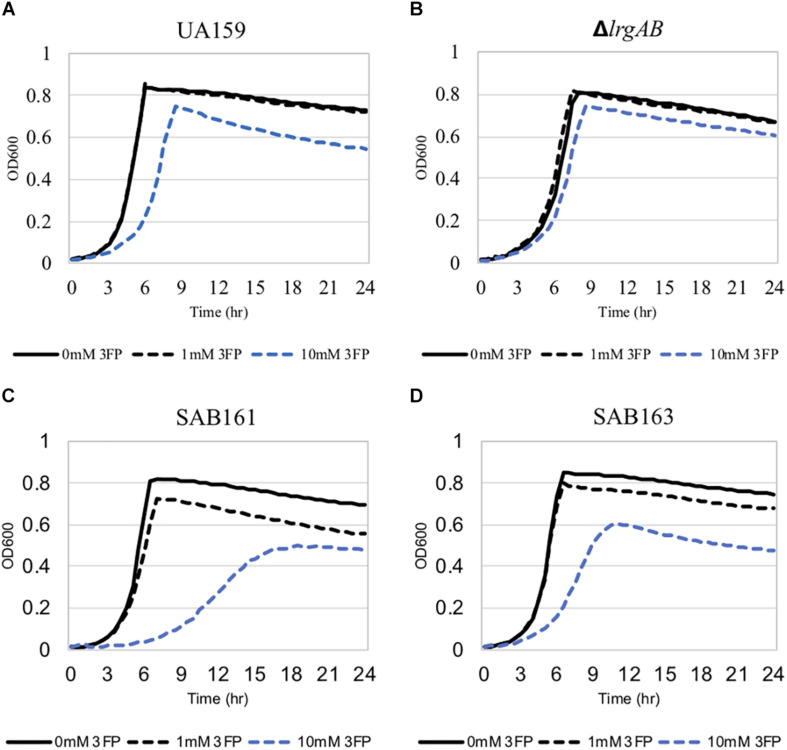
The effect of 3-fluoropyruvate (3FP; pyruvate analog) on the growth of the lrg-derivative strains. The strains, including S. mutans UA159 (WT, A), ΔlrgAB (lrgAB-deficient, B), SAB161 (lrgAB-overexpressing, C), and SAB163 (lytST-overexpressing, D), were cultivated in BHI medium supplemented by different concentrations of 3FP (0, 1, and 10 mM). Optical density at 600 nm was monitored every 30 min at 37°C using the Bioscreen C lab system. The results are representative of three independent experiments.